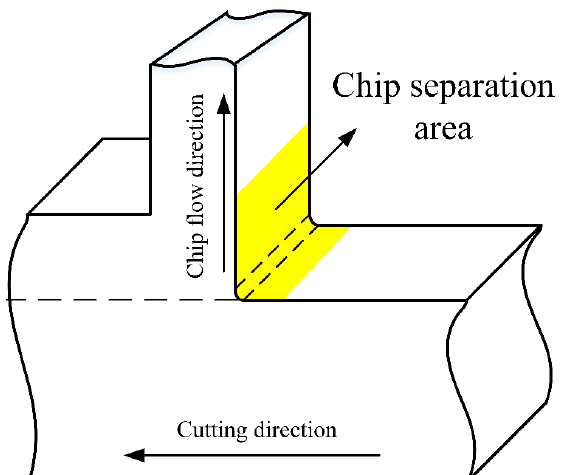
Figure 14. Schematic of chip root sample and chip separation area.